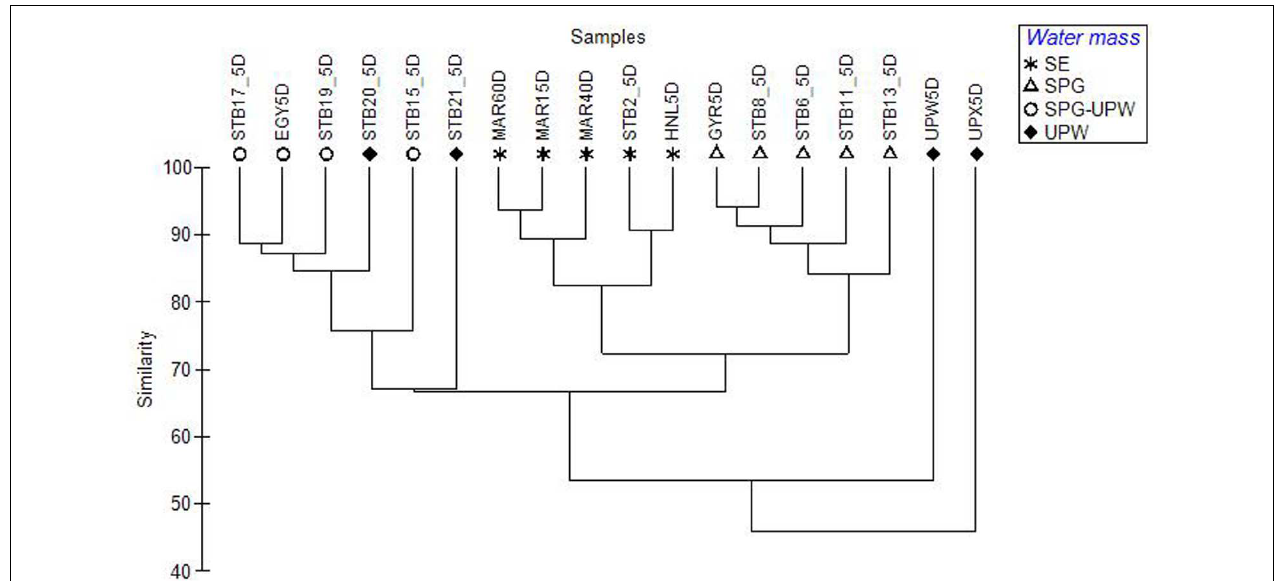
FIGURE 4 | Dendrogram constructed from a Bray–Curtis dissimilarity matrix of SSCP profiles from surface mixed layer samples across the BIOSOPE transect, showing the structuring of the bacterial communities according to water